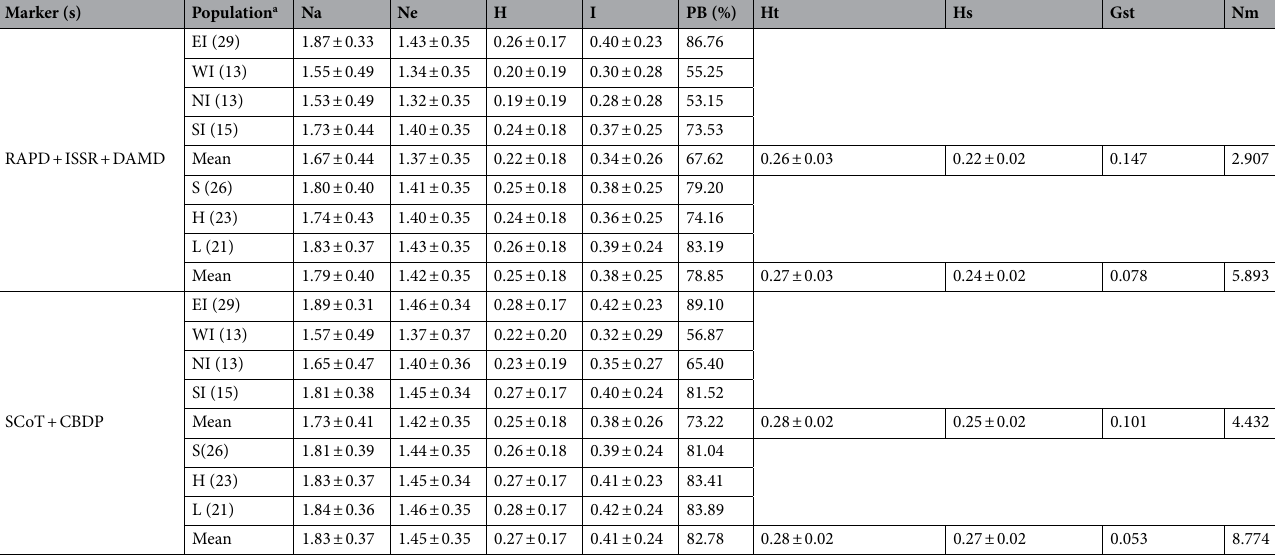
The combined marker techniques, SCoT + CBDP as well as RAPD, ISSR + DAMD also experienced similar pat- tern for values of Na (1.84, 1.83), Ne (1.46, 1.43), H (0.28, 0.26), I (0.42, 0.39) and PB% (83.89%, 83.19%), with the highest value observed in genotypes of local population (L). The population of Selection genotypes (S) exhibited higher variability than that of hybrids (H) (Na = 1.80 / 1.71, Ne = 1.44 / 1.42, H = 0.26 / 0.25, I = 0.39 / 0.37, PB% = 79.89 / 71.26) as noticed by ISSR markers. The SSR and CBDP markers experienced a similar trend in terms of variability quantities for selection and hybrid popu- lations. Interestingly, CBDP and SSR markers had higher mean values of Na (1.87, 1.88) across all the popula- tions compared to SCoT and RAPD (1.80), ISSR (1.78) and DAMD (1.74). Average values for other parameters like Ne (1.51), H (0.29), I (0.45), PB% (86.95), Ht (0.32) and Hs (0.30) were highest for SSR. The gene targeted markers CBDP and SCoT had Ne (1.45, 1.44), H (0.27, 0.26), I (0.41, 0.40), PB% (84.05, 80.28), Ht (0.28, 0.27) and Hs (0.27, 0.26), respectively. Considering different arbitrary markers, the mean effective number of alleles (Ne), Nei’s genetic diversity (H), Shannon’s information index (I) and total genetic diversity (Ht) was found to be maximum for ISSR (1.43, 0.26, 0.39, 0.27), followed by RAPD (1.41, 0.25, 0.35, 0.27) and DAMD (1.36, 0.22, 0.34, 0.23), respectively. Higher PB% values were found in RAPD (80.48) followed by ISSR (77.78) and DAMD (74.51), while another critical genetic diversity parameter, i.e. Hs (genetic diversity within population) was equally higher for ISSR and RAPD (0.26, 0.25) compared to DAMD (0.22). Gene targeted markers had higher levels of diversity in terms of average Na (1.83), Ne (1.45), H (0.27), I (0.41), PB% (82.78), Ht (0.28) and Hs (0.27) than those from arbitrary ones Na (1.79), Ne (1.41), H (0.25), I (0.38), PB% (78.85), Ht (0.27) and Hs (0.25). Gst value was the highest in RAPD (0.115) followed by SSR (0.07), DAMD (0.065), ISSR (0.061), CBDP (0.054) and SCoT (0.053). This indicated the superior ability of the RAPD markers to evaluate the variation among local, hybrid and selection genotypes, whilst the trend for gene flow (Nm) among the populations was the reverse, being the highest for SCoT (8.91) followed by CBDP (8.71), ISSR (7.65), DAMD (7.19), SSR (6.56) and RAPD (3.82). Analysis of molecular variance (AMOVA). Variability across geographical populations. Hierarchical AMOVA study was performed to estimate population differentiation among selected mango genotypes. The pre- sent study with different six marker systems showed that geographic variation was partitioning between 3–13% and maximum variation was present within geographic populations (87–97%). RAPD data showed 9% variation partitioned among geographic populations, whereas 91% variation was existent within the geographic popula- tions (Fig. 1Aa, Supplementary Table S1). Similarly, ISSR based AMOVA analysis showed 5% and 95% variation among and within populations, respectively (Fig. 1Ab, Supplementary Table S1). DAMD marker based AMOVA analysis accounted for 12% variation among geographic populations and 88% variation within geographical populations (Fig. 1Ac). SCoT marker based AMOVA analysis showed the least variation among populations (3%) and maximum variation (97%) within populations (Fig. 1Ad).With CBDP marker, 4% variation was ac- cumulated within populations while between populations it was 96% (Fig. 1Ae, Supplementary Table S1). Of all the six marker systems used for AMOVA analysis, SSR marker based analysis showed maximum variation